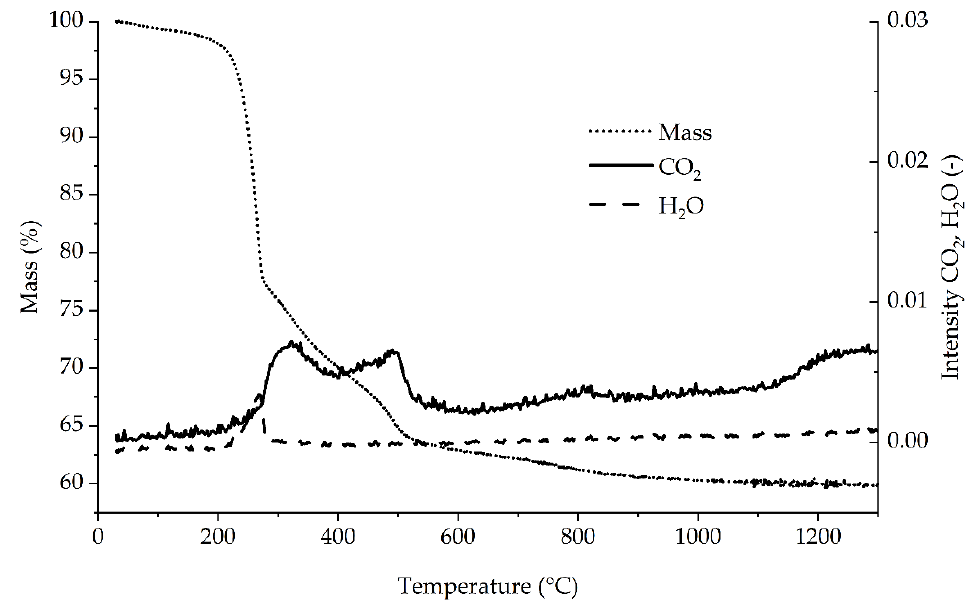
Figure 7. TGA-IR analysis of the treated Al 4 C 3 powder sample (4 h at 70 °C) in air. Starting at 30 °C with a temperature ramp of 5 °C/min.